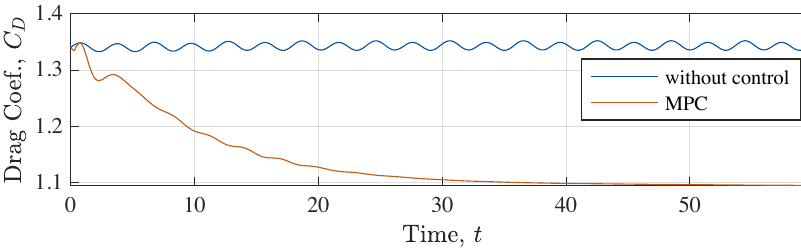
Figure 5. History of the drag coefficient. (Blue line: Without control, Red line: With